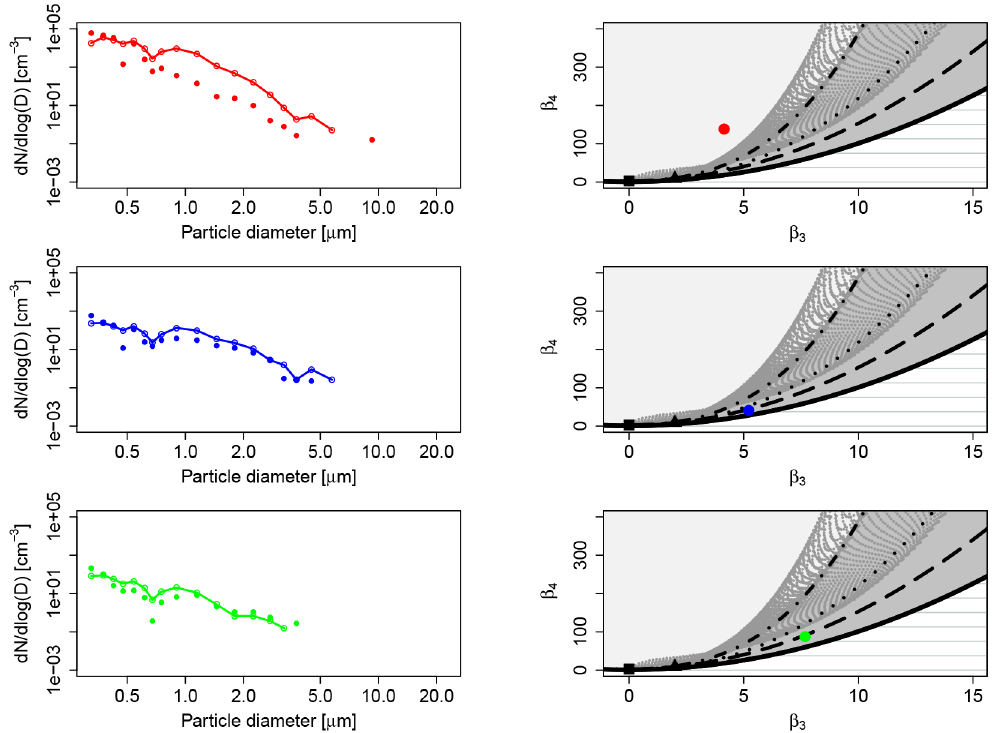
Figure 4. Comparison of empirical PNSDs (dots) and JSB fittings (lines) from MI3 (red), MI8 (blue) and SC2 (green), first column. Corre- spondent location of the (β 3 ,β 4 ) couples in the (S–K) plane, second